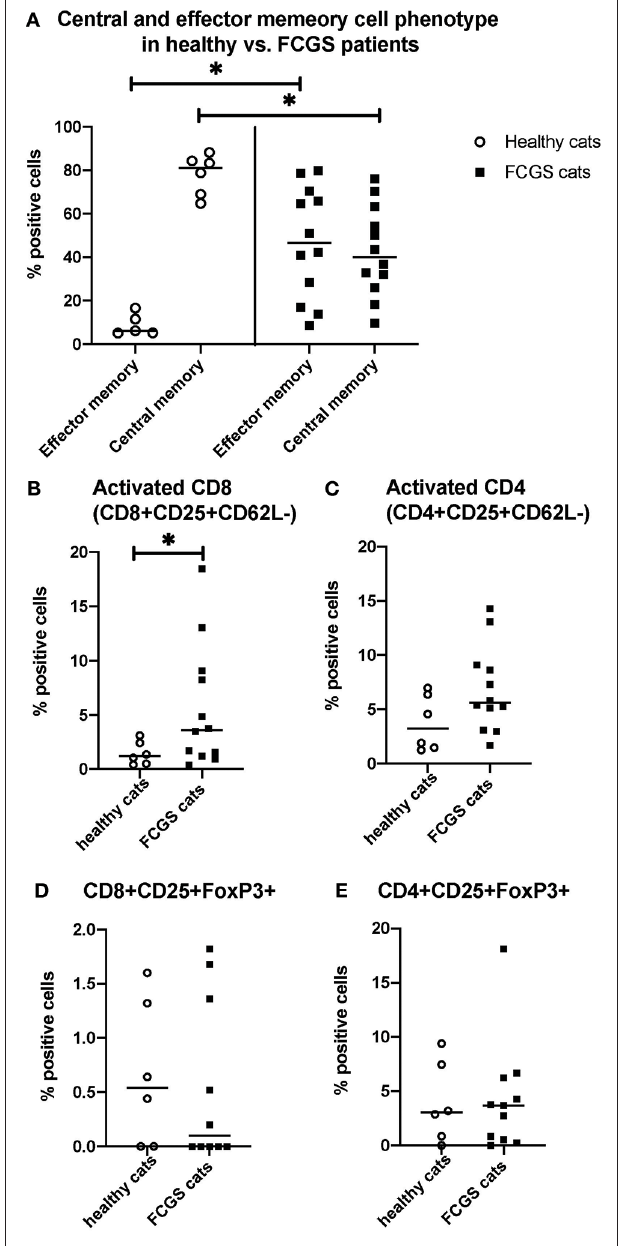
FIGURE 3 | Quantitative assessment of selected immunophenotypes in the circulation of FCGS ( n = 12) patients compared to healthy controls ( n = 6), respectively. Significant differences are highlighted by a line with and asterisk. The Y axes reflect the percentage of immunoreactive cells relative to the total lymphocyte population in the sample. (A) Percentages of central and effector CD8 + cells in the systemic circulation in healthy and FCGS patients. Percentage of the effector memory (CD8 + CD45-CD62L − ) lymphocytes is significantly higher in FCGS patients than in healthy controls ( p < 0.05). Percentages of central memory (CD8 + CD45-CD62L + ) lymphocytes are significantly lower in FCGS patients than in healthy controls ( p < 0.05). (B) Percentages of activated CD8 + cells are significantly higher in the circulation of FCGS patients than in healthy controls ( p < 0.05). (C) Percentages of activated CD4 + cells are trending higher than in healthy controls. (D,E) Percentages of CD25 + FOXP3 + CD8 + and CD25 + FOXP3 + CD4 + lymphocytes, respectively, are trending higher in the FCGS